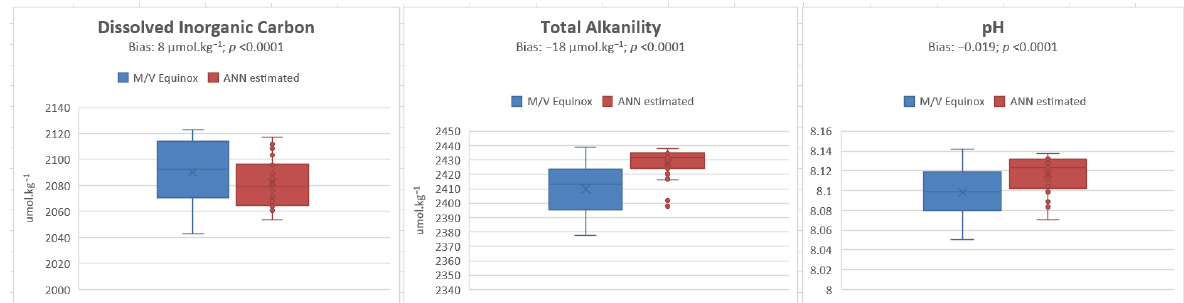
Figure 6. Median and variability of ANN-estimated values fall within those shown by discrete underway measurements (Autumn 2016 cruise transect). The means of the two datasets are similar at the 99% C.L.